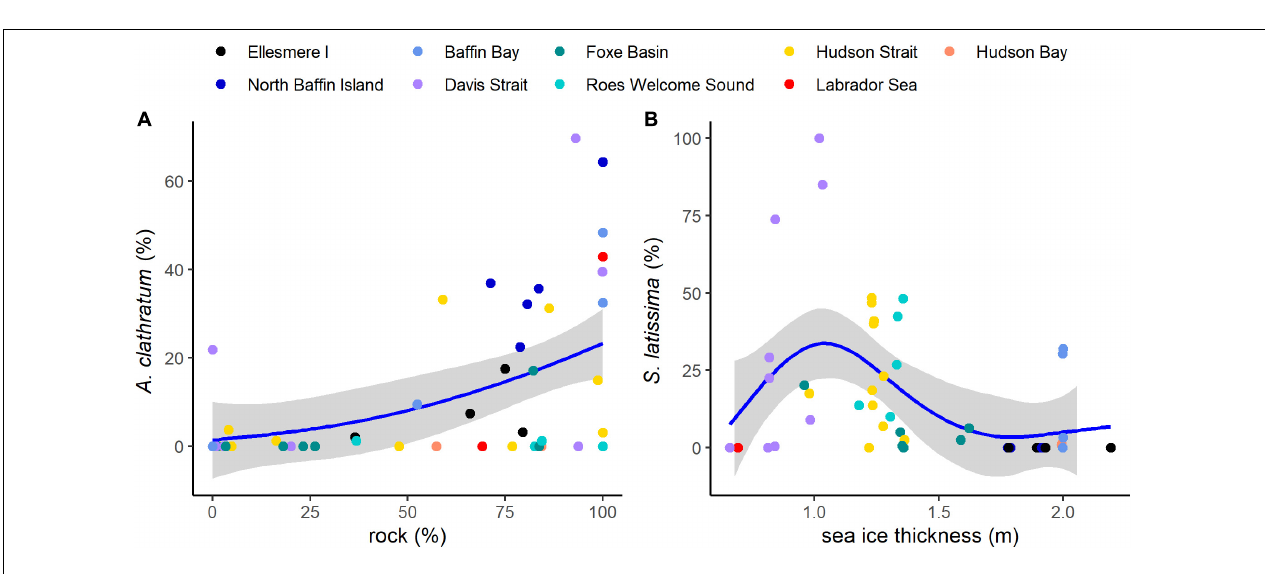
percentage of the substratum composed of boulders 14.4% ( ±